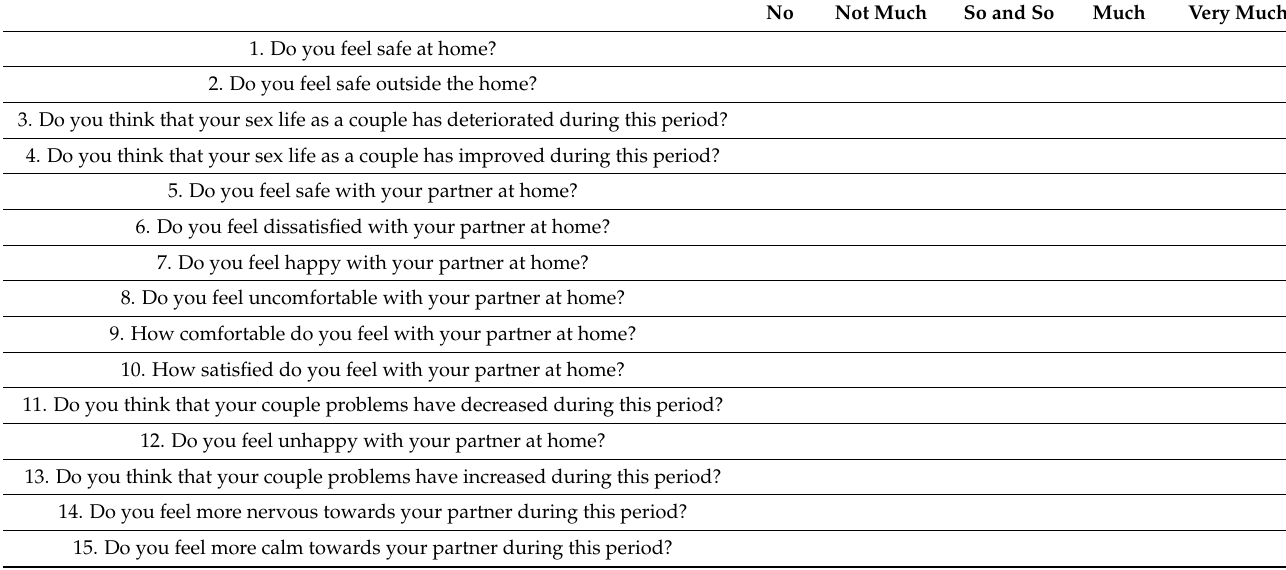
Table 1. Questions concerning the coronavirus disease 2019 (COVID-19) pandemic and its effect on couples’